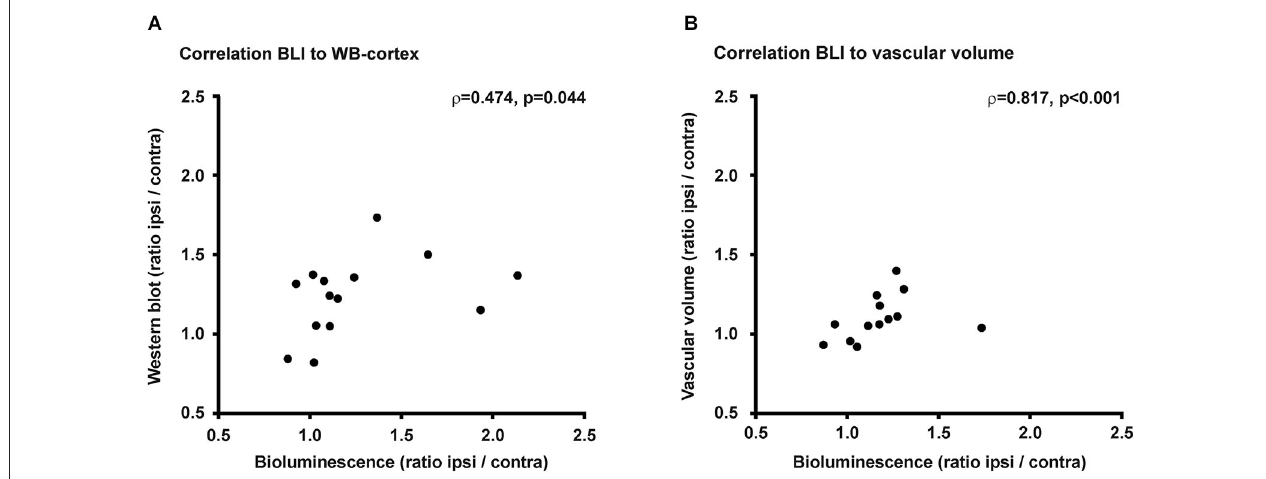
FIGURE 6 | Correlations. (A) Changes of PE within the ischemic hemisphere correlates to VEGFR2 protein changes in the ischemic cortex ( ρ = 0.474, p = 0.044). (B) Photon emission increase also correlates to vascular volume changes within the ischemic hemisphere ( ρ = 0.817, p < 0.001).